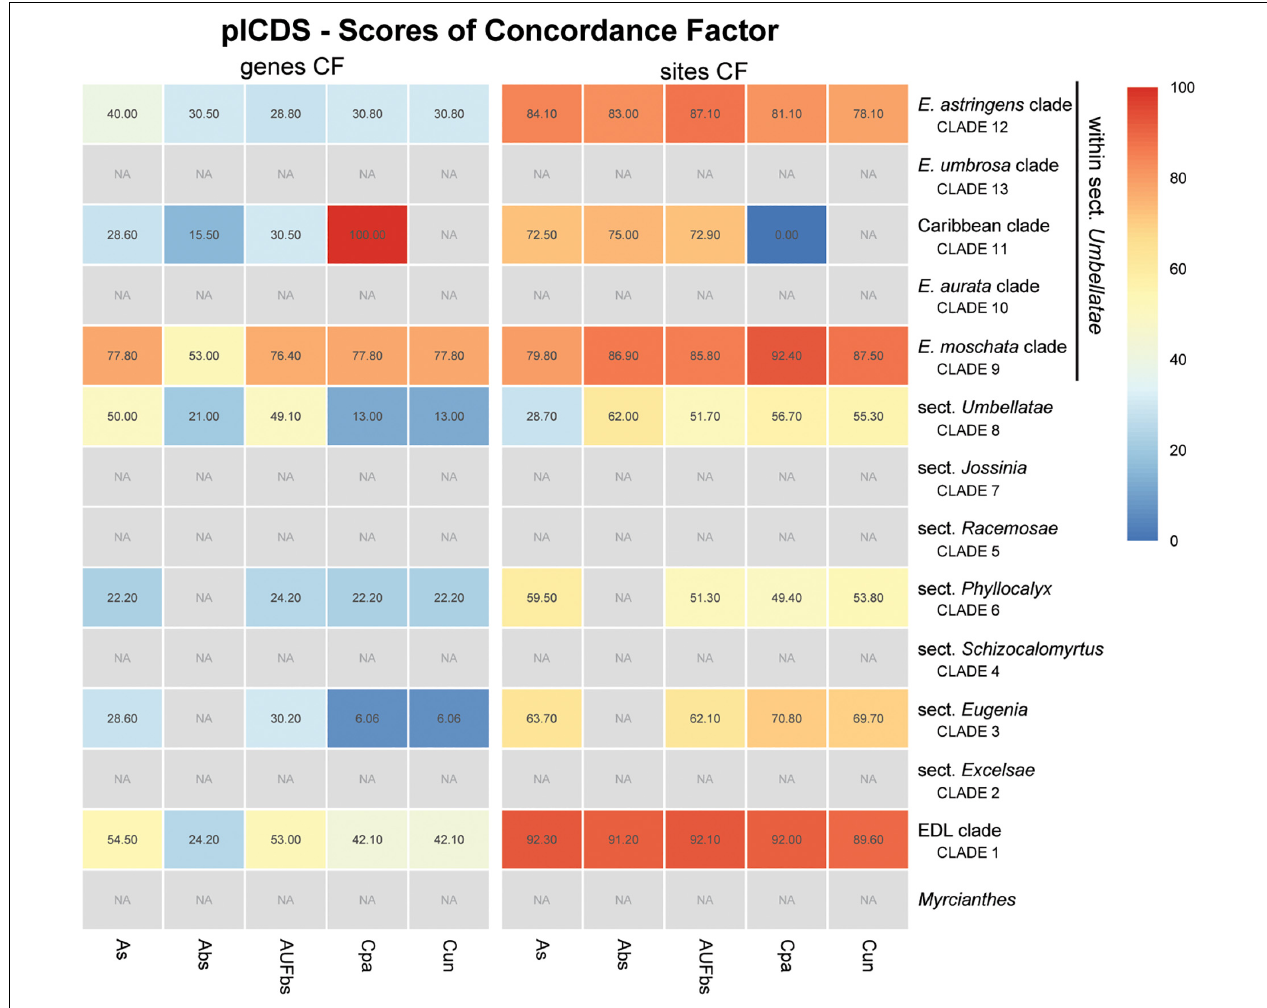
FIGURE 9 | Heatmap of gene and site concordance factors (gCF and sCF) recovered in focus clades of the plastome coding loci (plCDS) in Eugenia . Each column is a method of phylogenetic reconstruction, and each row corresponds to a clade in Figures 2–4 . Shading indicates percentage of concordance factor values recovered (Cpa, concatenated and partitioned ML reconstruction; Cun, concatenated and unpartitioned ML reconstruction; As, coalescent Astral tree with local posterior probability support; Abs, coalescent-based Astral tree with 100 bootstrap replicates; AUFbs, coalescent Astral tree with 1,000 ultrafast bootstrap replicates; NA, node not